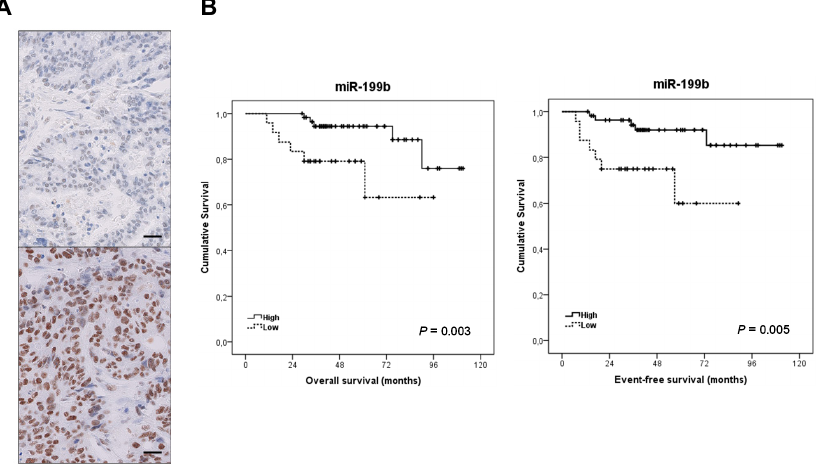
Figure 5. Clinical significance of the miR-199b/SET axis in LARC. ( A ) Immunohistochemical detection of SET in LARC patients showing SET-negative and positive stainings. The line shows 25 µm. Original magnification ×400; ( B ) Kaplan–Meier analyses for miR-199b expression in LARC patients.